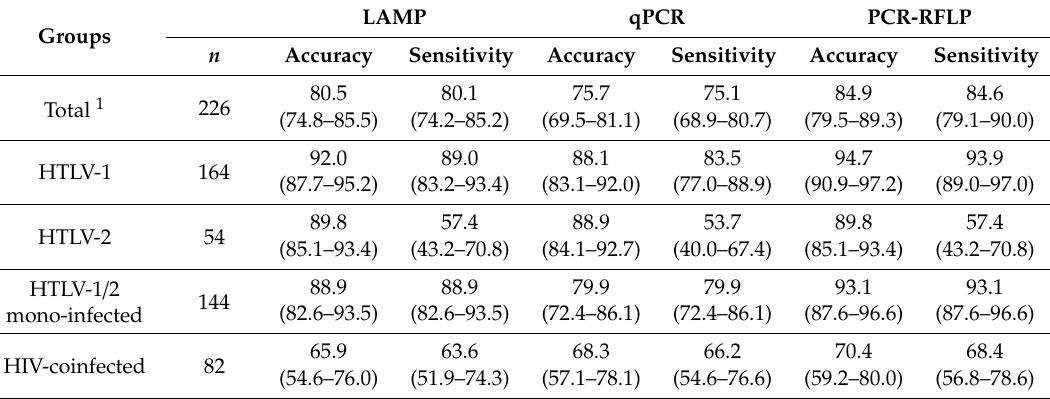
Table 2. Accuracy and sensitivity of LAMP, qPCR and PCR-RFLP assays for HTLV-1 / 2. Groups